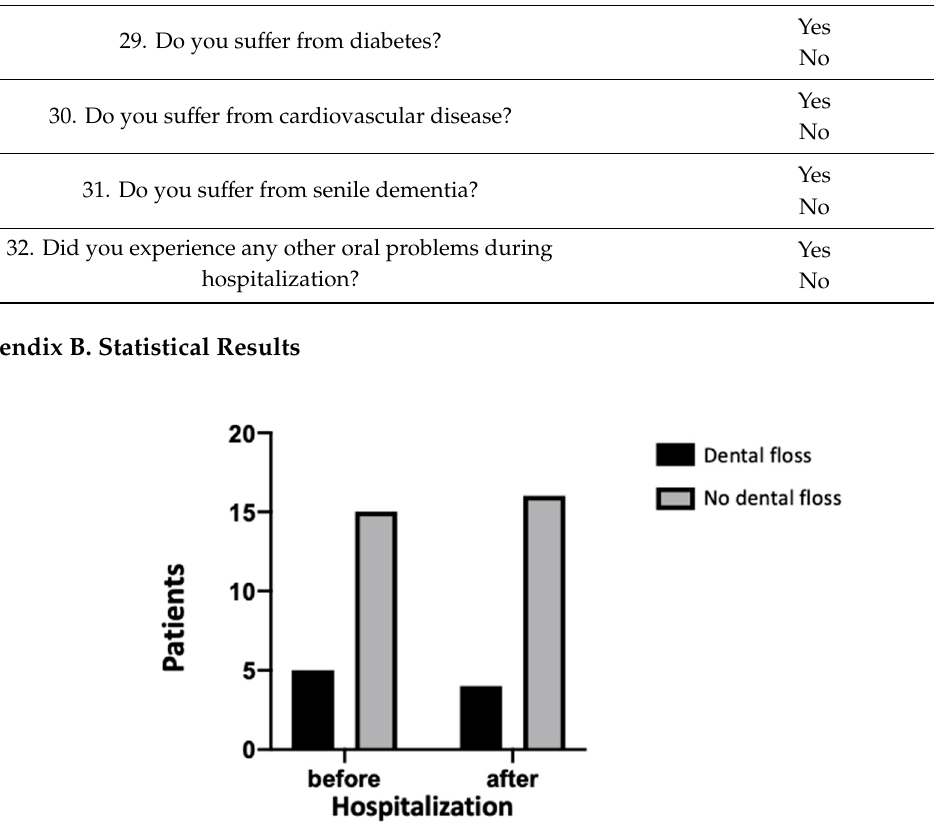
Figure A1. Use of dental floss before and after hospitalization of the patients. No statistical difference was shown between the study time points ( p > 0.99).